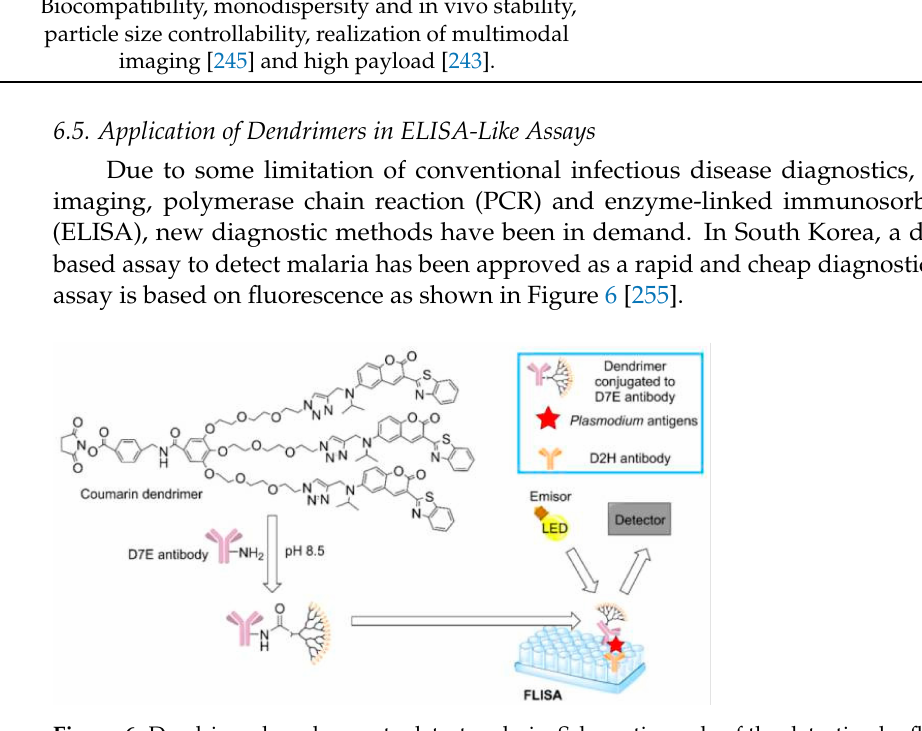
Figure 6. Dendrimer-based assay to detect malaria. Schematic mode of the detection by fluorescence- linked immunosorbent assay (FLISA)